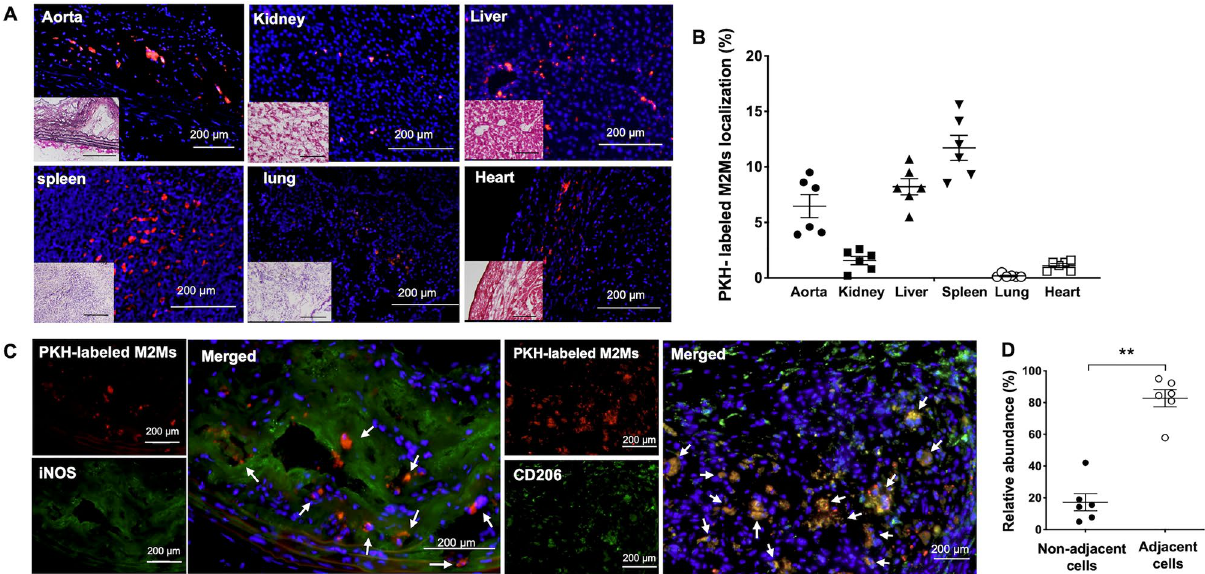
Figure 5. Distribution of injected M2Ms. ( A ) PKH-labeled M2Ms detected in the aorta, kidney, liver, spleen, lung, and heart. Scale bars = 200 µm. ( B ) The percentage of total cells in each tissue that were PKH-labeled M2Ms (n = 3 mice). Data are means ± SEM. ( C ) Representative images of immunofluorescence staining for iNOS and CD206 expressed on PKH-labeled M2Ms. ( D ) Relative abundance of PKH-labeled M2Ms that were localized next to iNOS. Data are means ± SEM. ** p < 0.01 assessed by the Mann–Whitney U test. M2M: M2